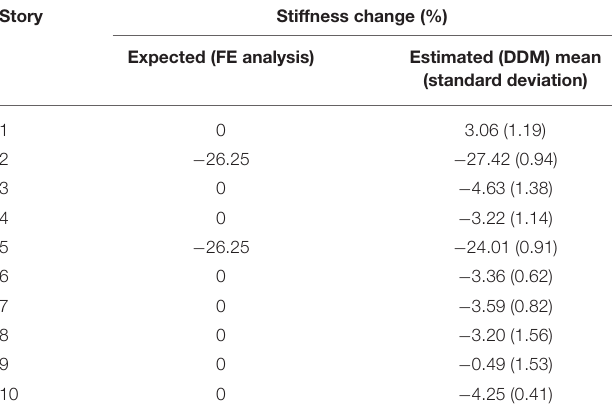
TABLE 7 | Story stiffness change (DC C1).